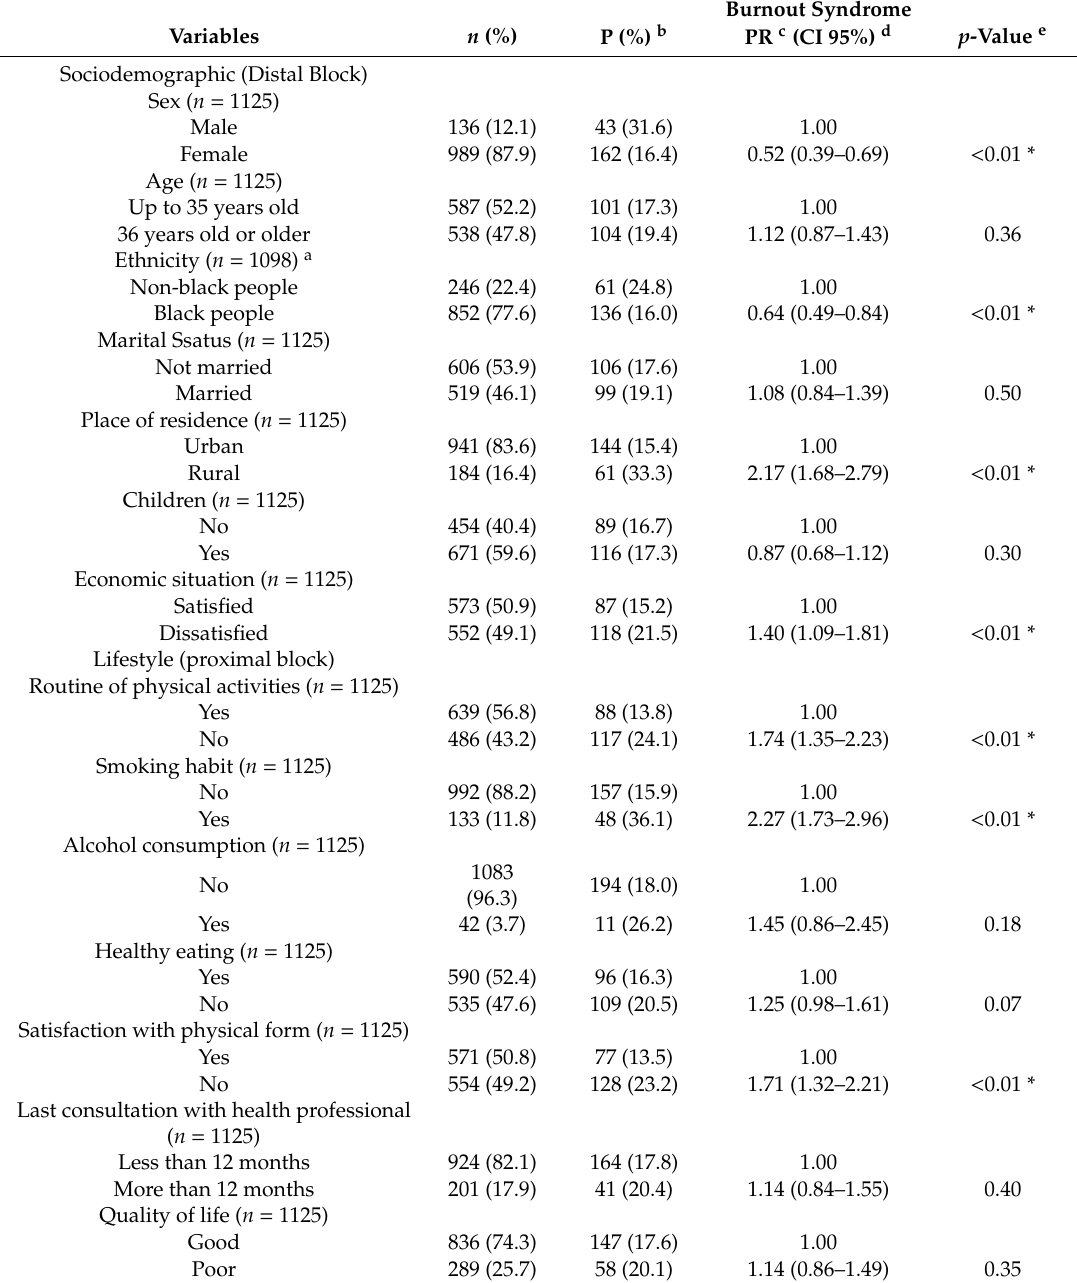
Table 2. Gross prevalence ratio of Burnout Syndrome and its 95% confidence intervals, according to sociodemographic and lifestyle variables in Primary Health Care nursing professionals in Bahia, Brazil in 2018 ( n =